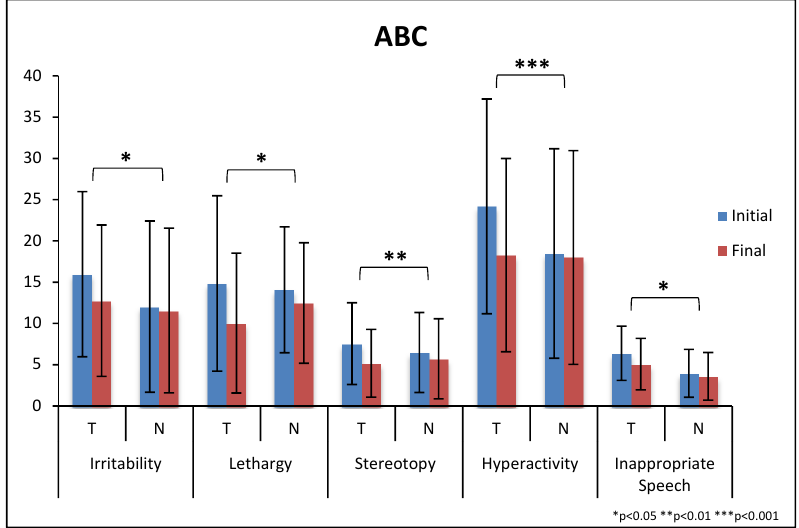
Figure 10. ABC subscales at beginning and end of the study. “T” refers to the treatment group and “N” refers to the non-treatment group. Higher scores represent greater severity. Error bars represent standard deviations.